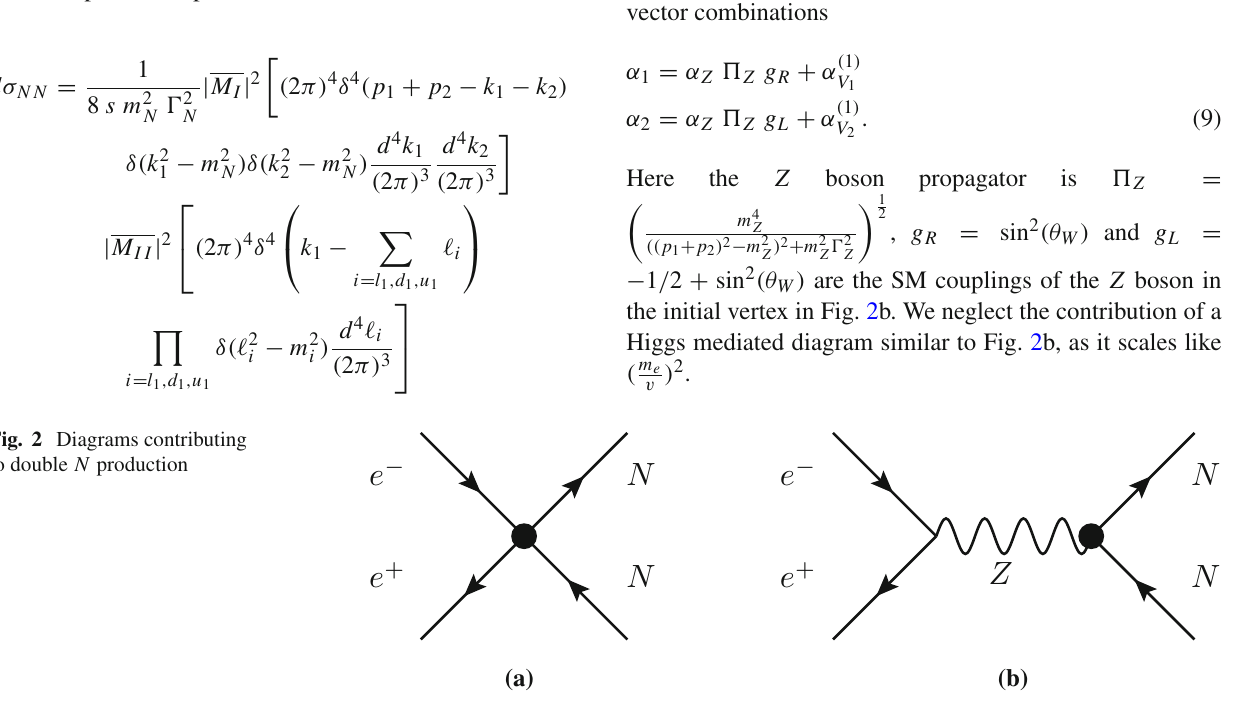
Fig. 2 Diagrams contributing to double N